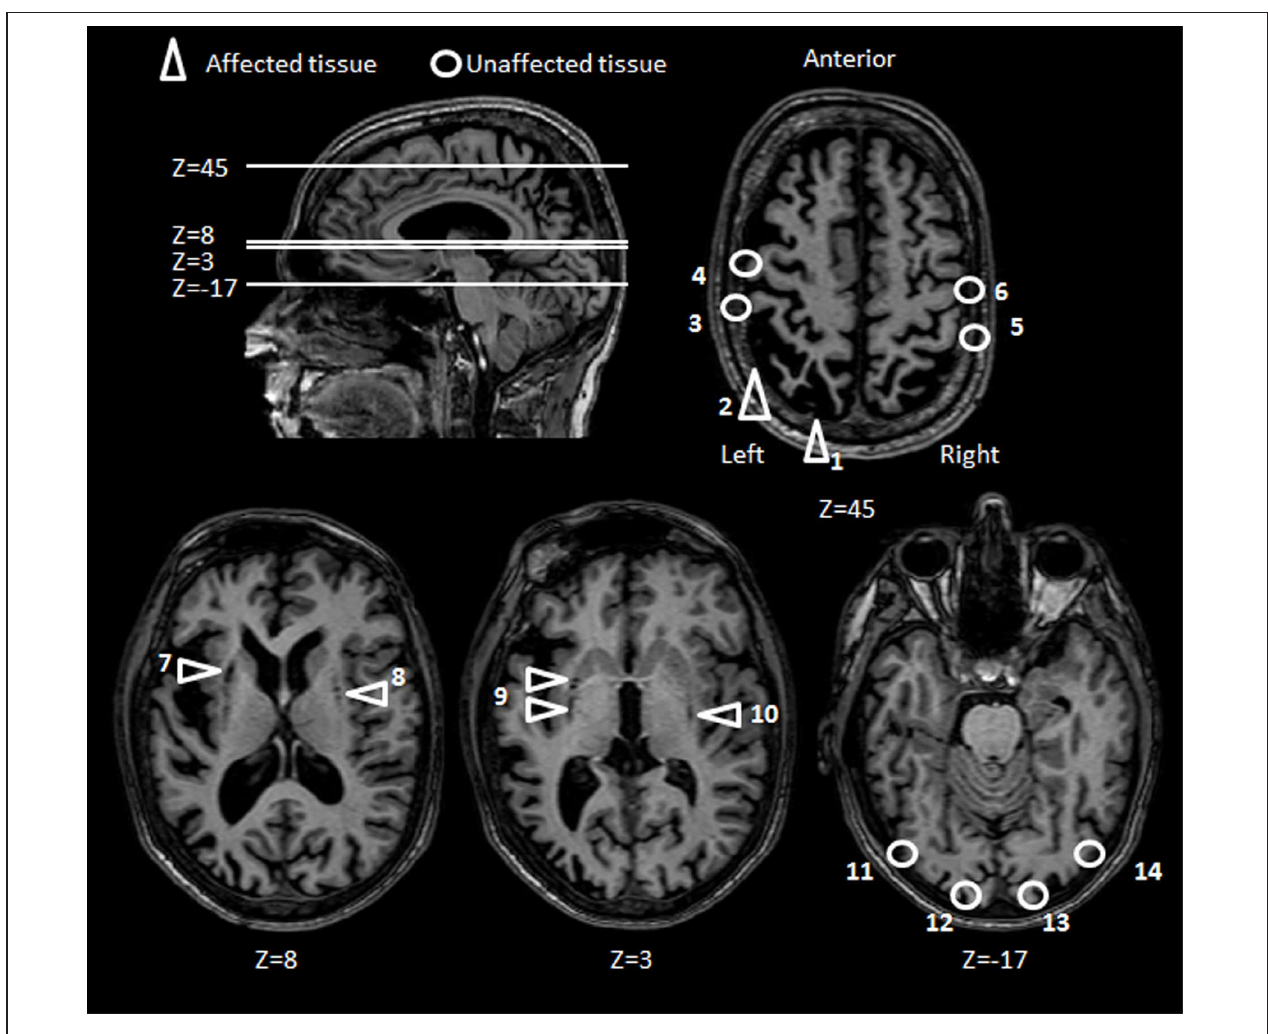
affected by the lesion include the left PPC (1, 2), and subcortical structures (7–10). Key sensorimotor and visual areas that have been spared by the lesions include bilateral post central (3, 5), central gyri (4, 6) bilateral striate (12, 13) and extrastriate visual cortices (11,